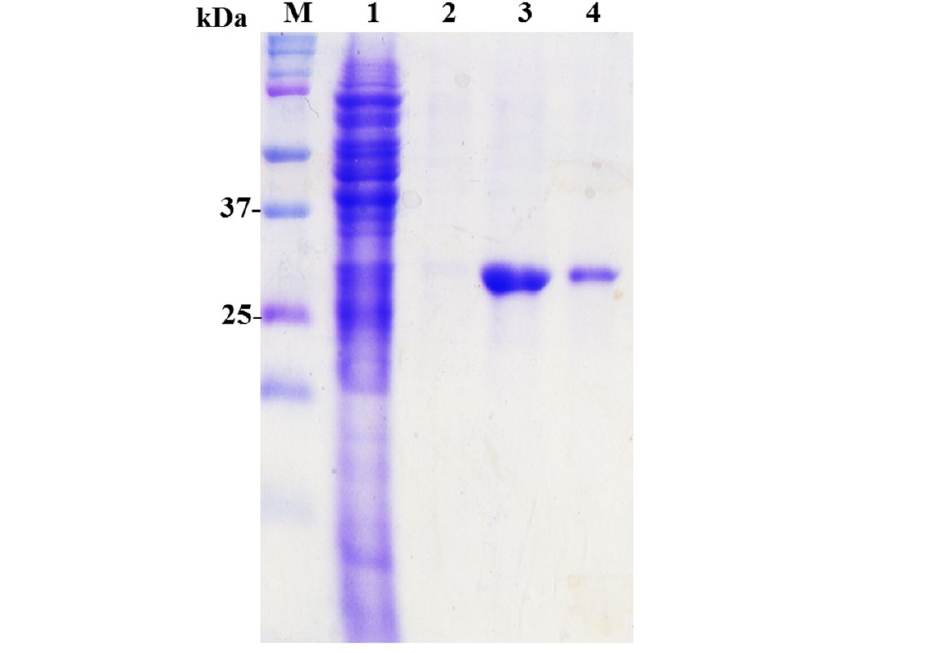
Figure 4. Purification of EV71S1 scFv antibody. After IPTG induction, the His-fused scFv was purified using Ni 2+ sepharose and analyzed on SDS-PAGE stained with Coomassie blue dye. The purity of recombinant scFv antibody is genuinely high as demonstrated in lane 3. The scFv antibody was not entirely removed from the Ni 2+ sepharose after elution (lane 4). Lane 1: flow through. Lane 2: washing. Lane 3: elution. Lane 4: